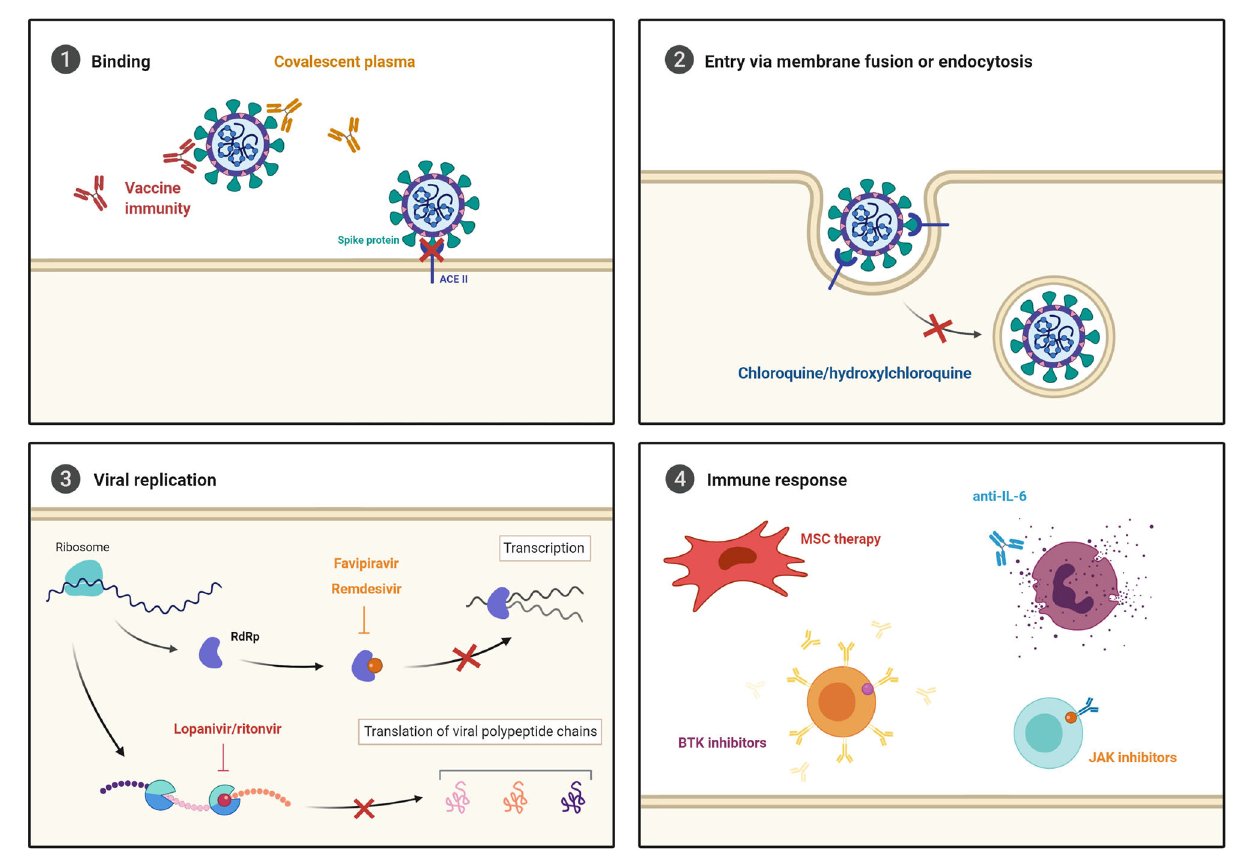
FIGURE 4 | Current COVID-19 treatment strategies. (1) Novel vaccines and convalescent plasma are being investigated to prevent viral entry. Broad-spectrum antiviral agents that inhibit (2) cell entry via endocytosis, and (3) viral replication through RNA-dependent RNA polymerase (RdRP) and protease inhibition are being repurposed to test efficacy against SARS-CoV-2. Furthermore, (4) immune modulating and anti-inflammatory treatments are being explored to prevent the development of severe COVID-19 development.